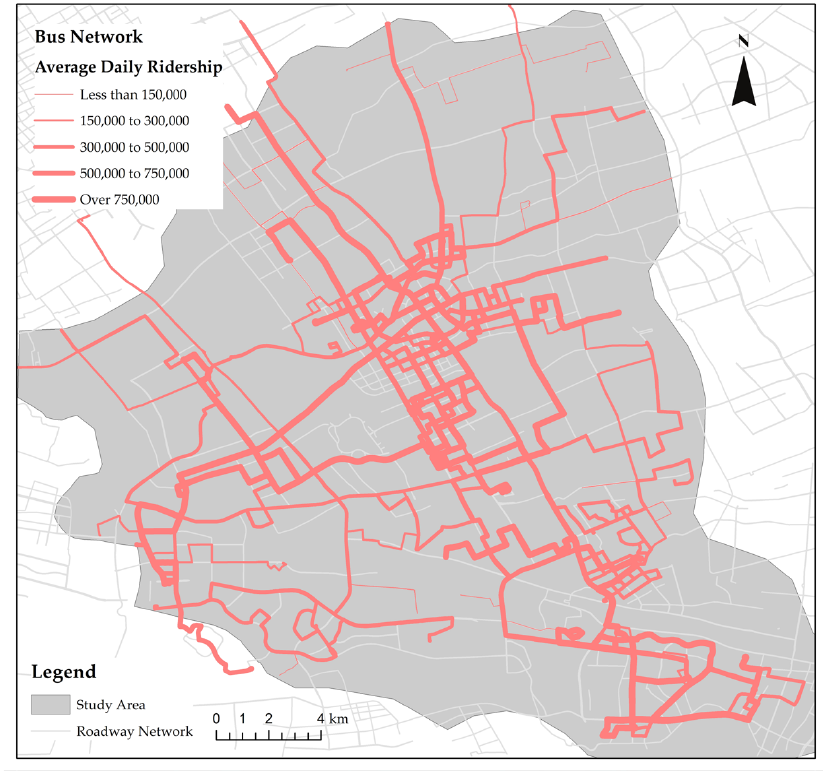
Figure 4. Bus network and the distribution of average daily ridership at bus line level .